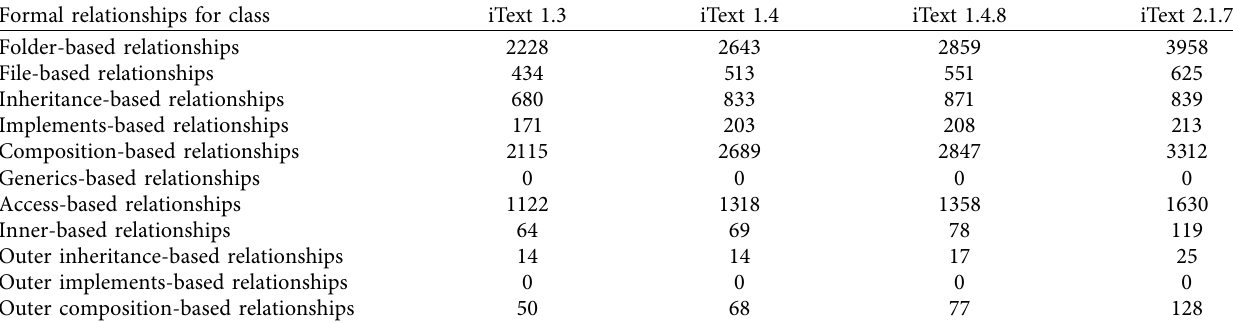
Table 8: Formal relationships for class in iText.